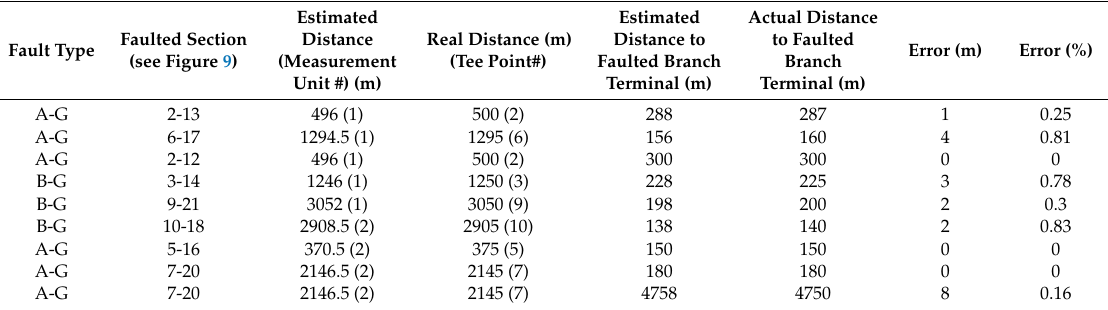
Table 3. Fault location for fault on the